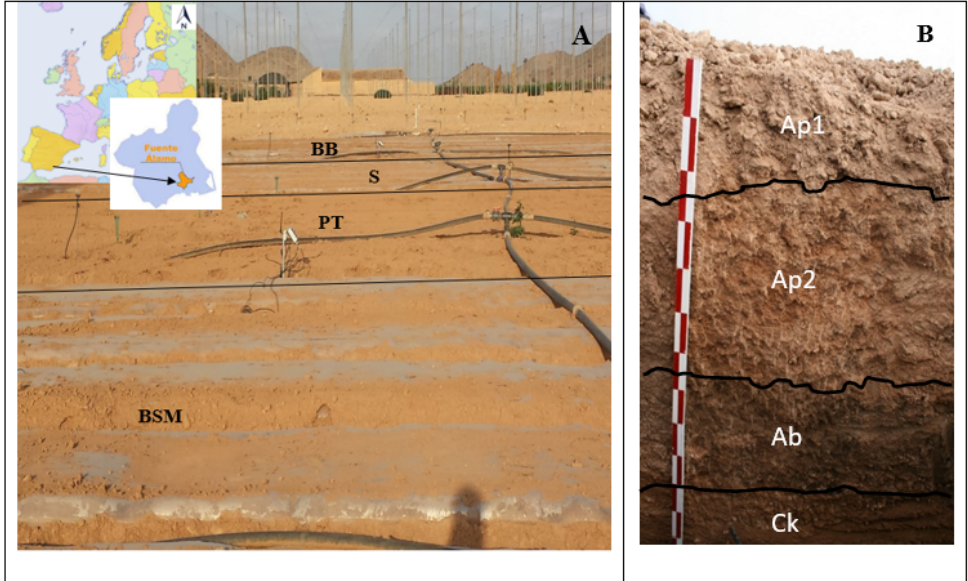
Figure 1. ( A ). Geographical location of the study area, and of the different treatments applied. BS: organic amendment of Brassica juncea L. with plastic, S: without organic amendment but with plastic, PT: control (no amendment and no plastic), BSM: organic amendment of sheep and poultry manure) and plastic. ( B ). Detail of soil profile.